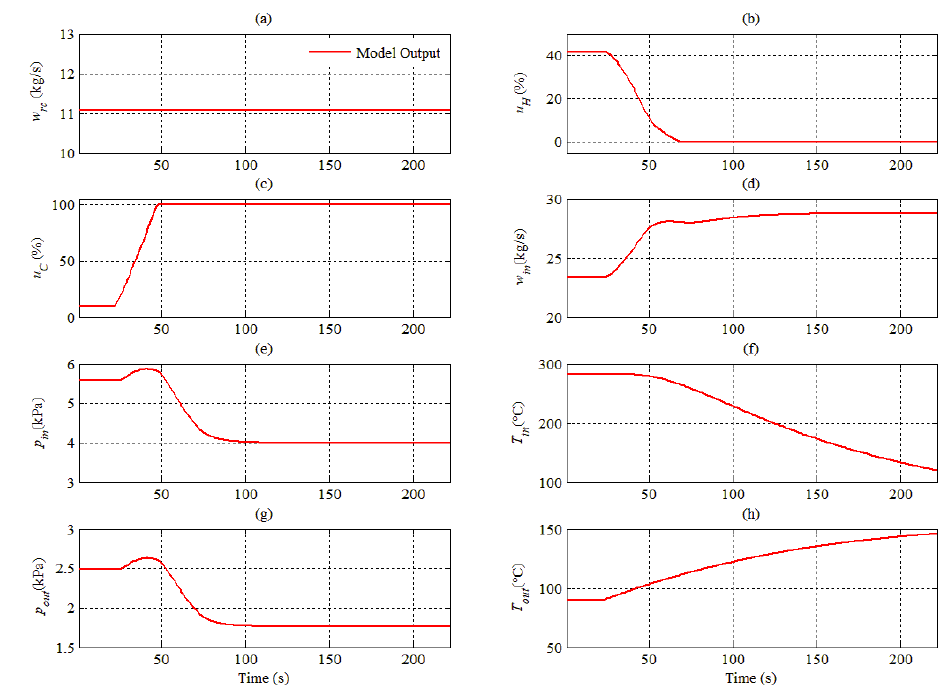
Figure 6. Simulation of coal self-ignition